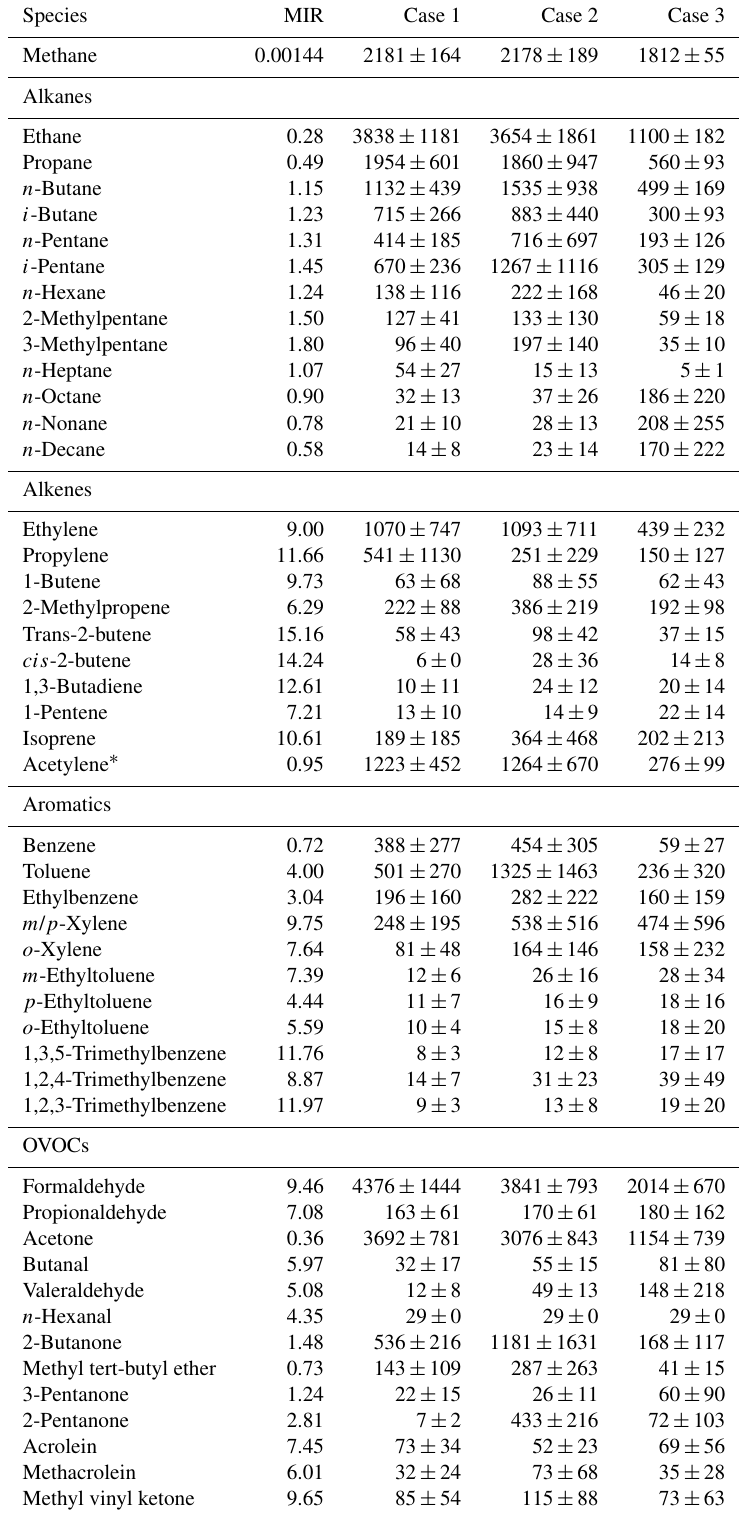
Table 2. Summary of the mixing ratios of measured VOCs (unit: pptv, except for ppbv of methane) in three cases and their maximum incremental reactivity (MIR; unit: gO 3 /gVOC, the ozone formation coefficient for VOC species in the maximum increment reactions of